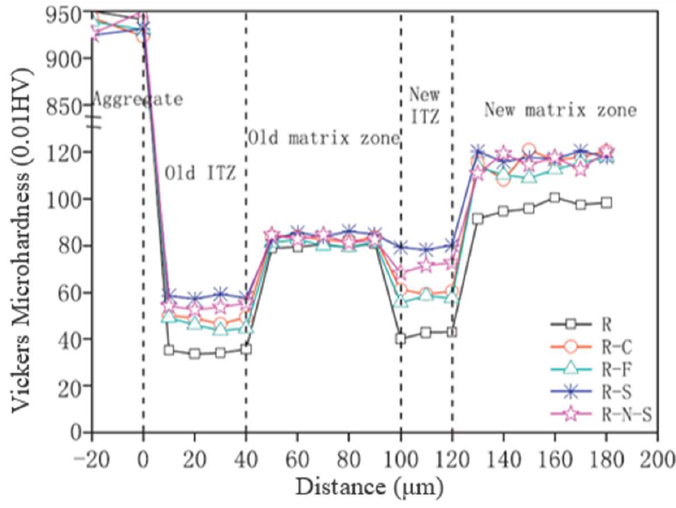
Figure 5. Microhardness of new and old ITZ [36]. Reproduced with permission from [36], Elsevier, 2018.